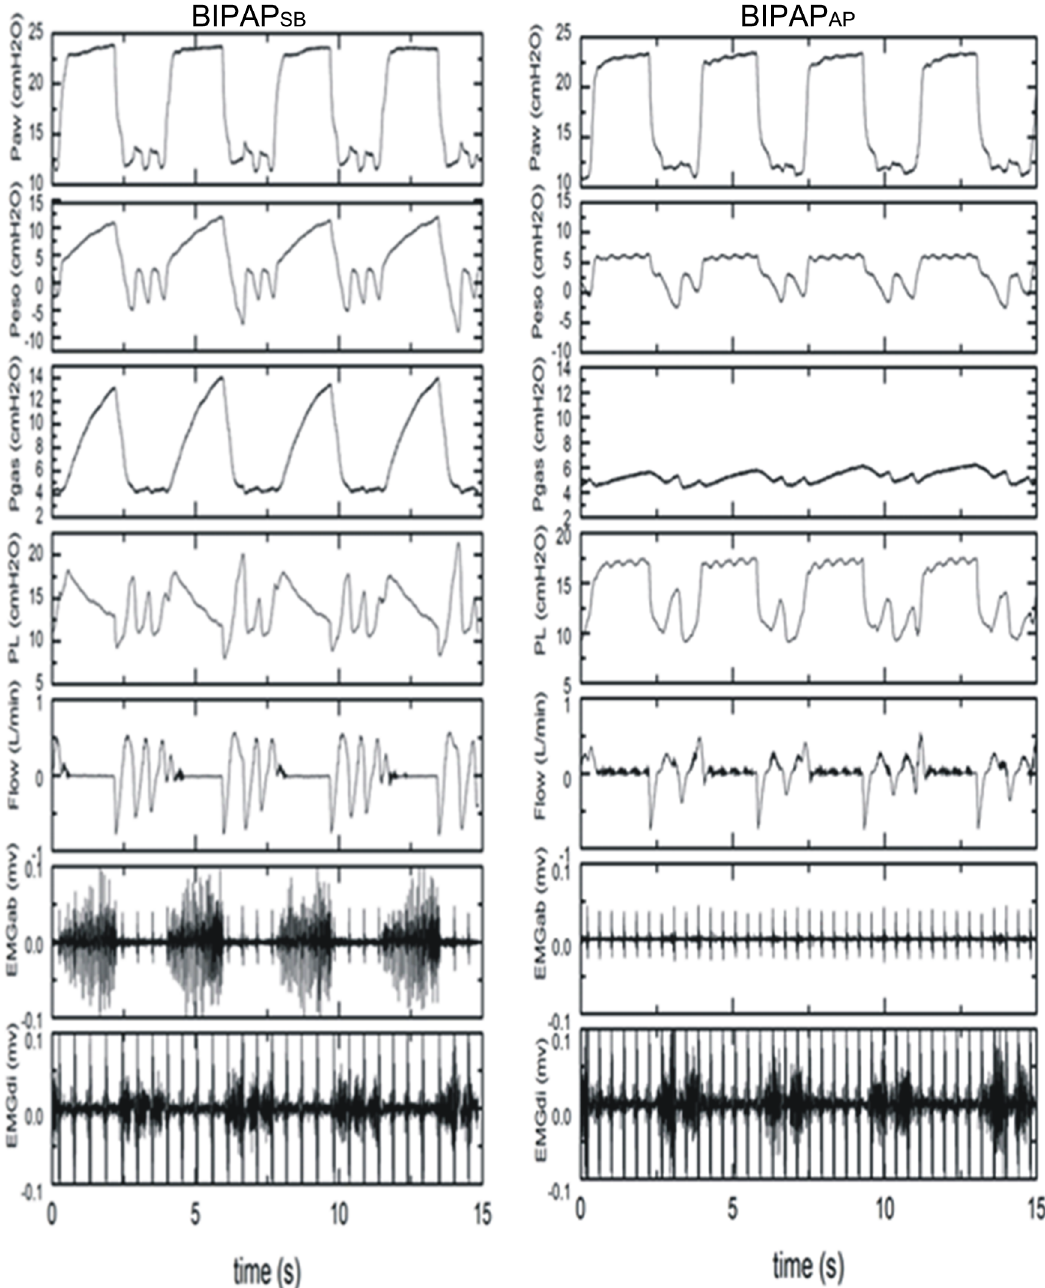
Fig 1. Representative respiratory tracings. Representative respiratory tracings of airway pressure(Paw), esophageal pressure (Pes), intragastric pressure (Pgas),transpumonary pressure (PL), Airflow abdominal muscles surface electromyography (EMGab)and diaphragmatic esophageal surface electromyography (EMGdi) in BIPAP SB ,BIPAP AP group in representative animals. BIPAP SB = biphasic positive airway pressure with SB; BIPAP AP = biphasic positive airway pressure with abdominal muscles paralysis.